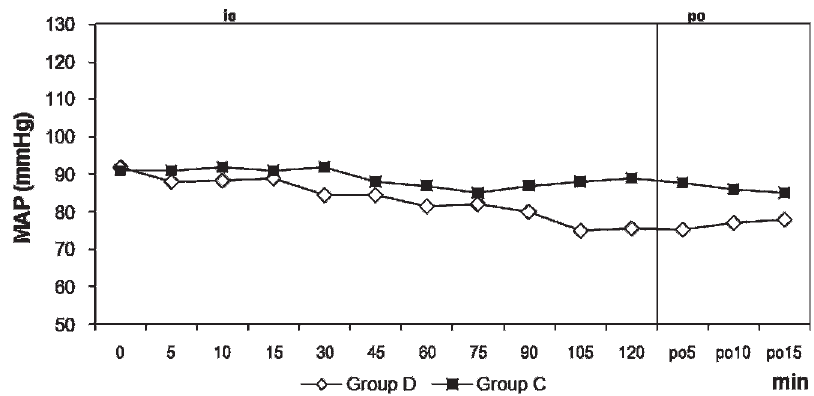
Figure 2 - Mean Arterial Pressures. MAP: Mean Arterial Pressure, io: intraoperative, po: postoperative, min; minute, Intraoperative and postoperative mean arterial pressure. + , 0.05 when two groups are compared.